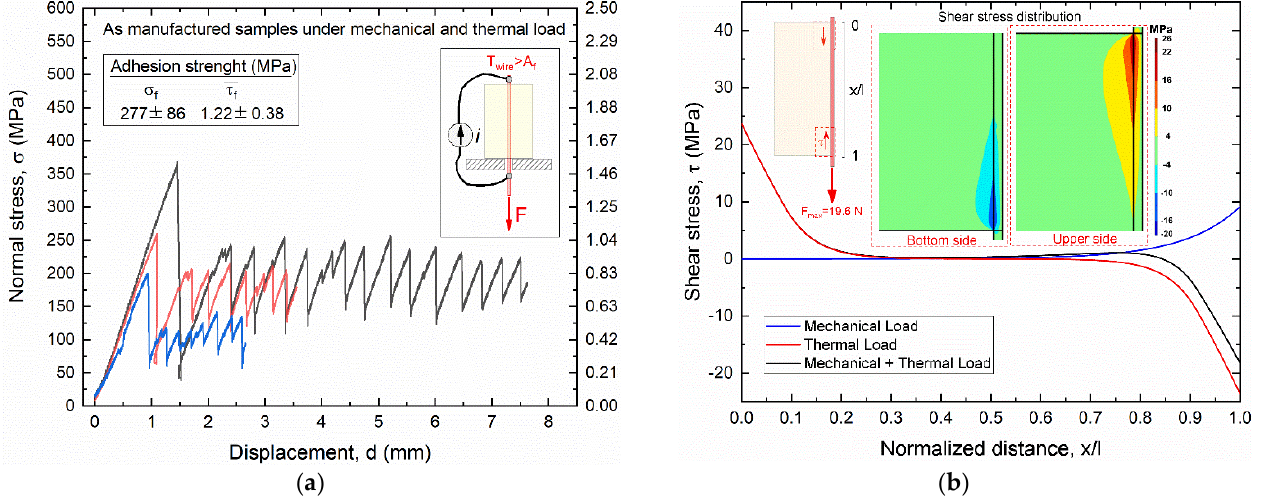
Figure 14. Results of static pullout tests of as manufactured samples subjected to mechanical loading and thermal activation of the SMA wire (load case #2): ( a ) experimental stress vs. displacement curves obtained from three different samples; ( b ) FE results of the shear stress distribution at the wire – resin interface along the contact length at the pullout force F max = 19.6 N.